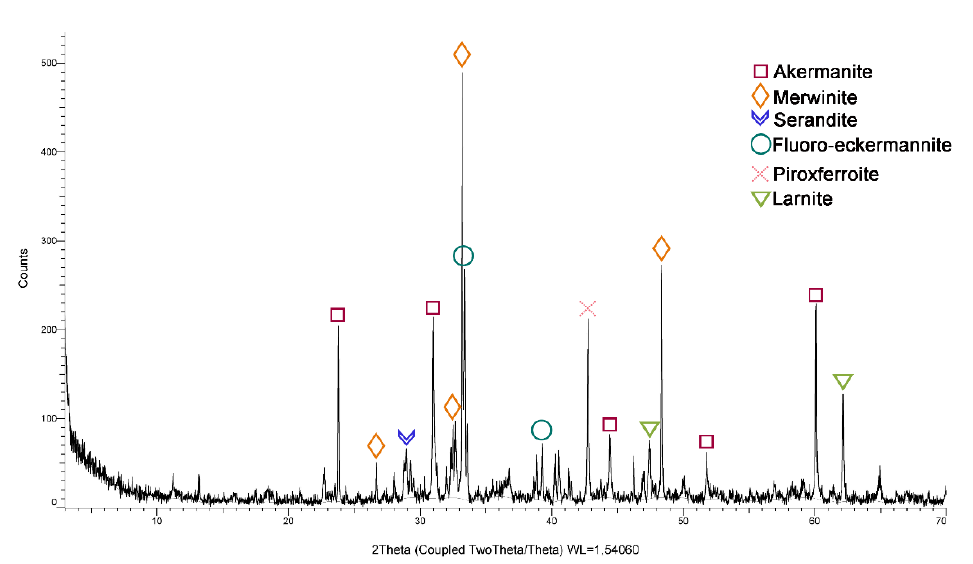
Figure 3. SSs mineralogical composition by X-Ray diffraction (DRX).